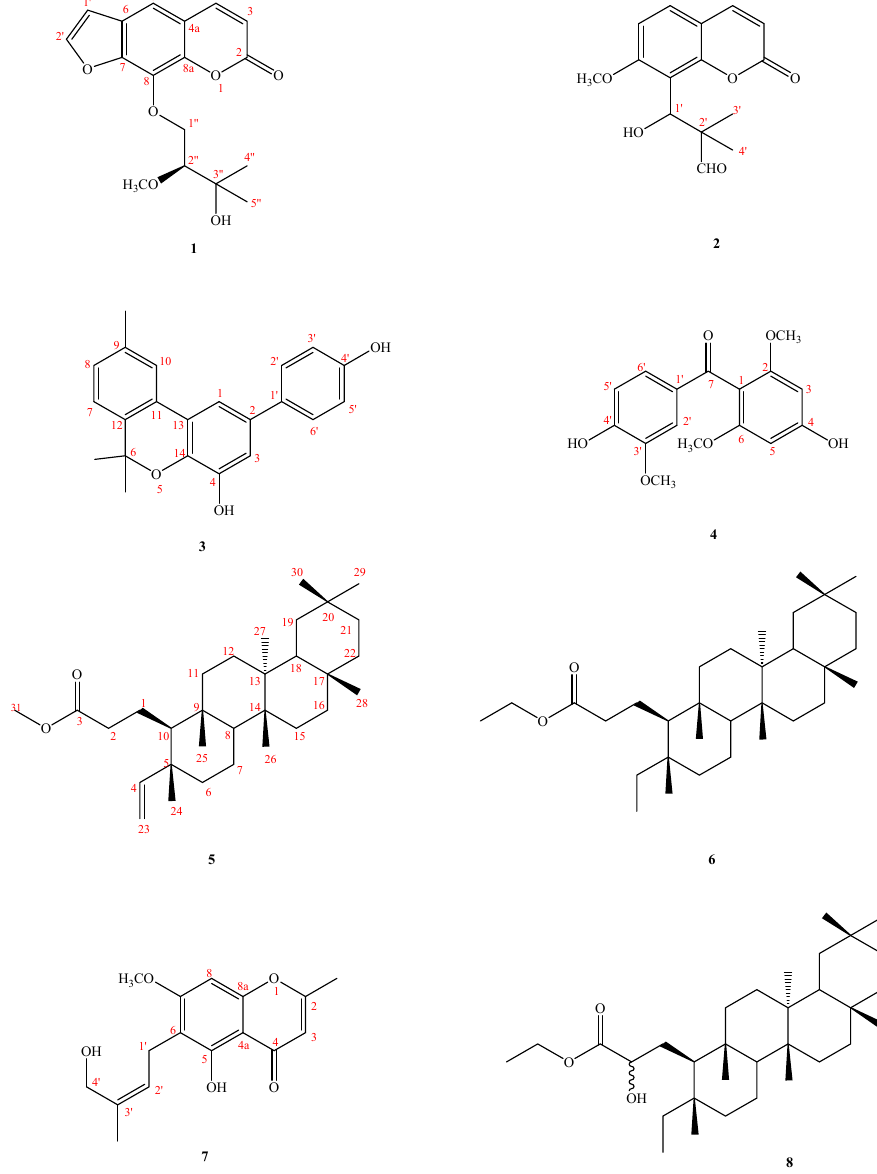
Figure 1. Compounds 1–8 , isolated from Herbidospora daliensis .